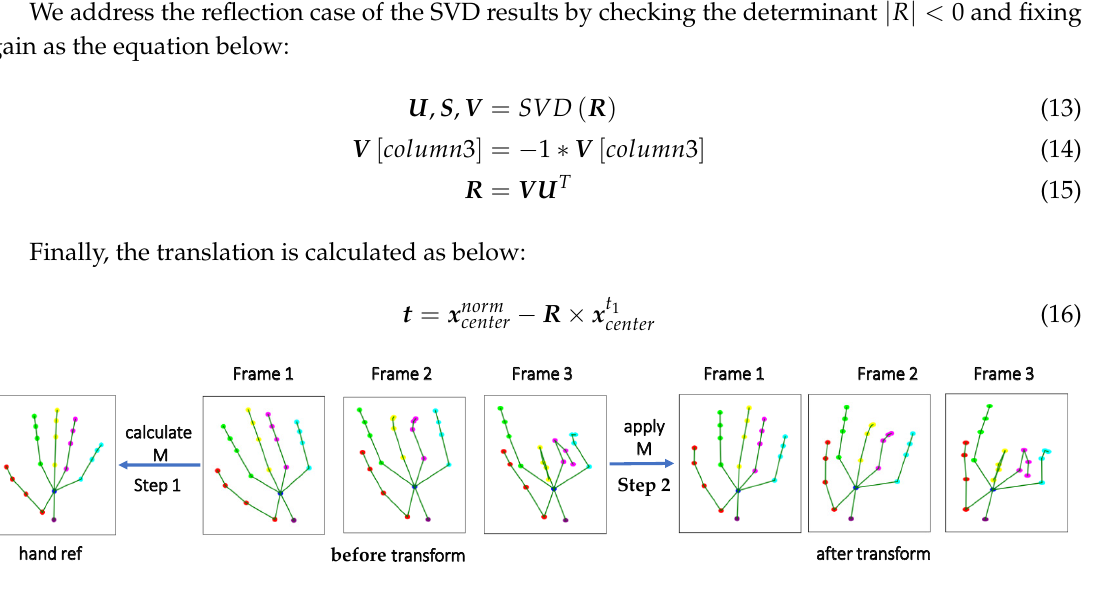
Figure 3. Hand skeleton normalization. We will calculate the rotation, translation, and uniform scale of the first hand skeleton to the reference hand skeleton. Then, the matrix transform will be applied to the remaining hand